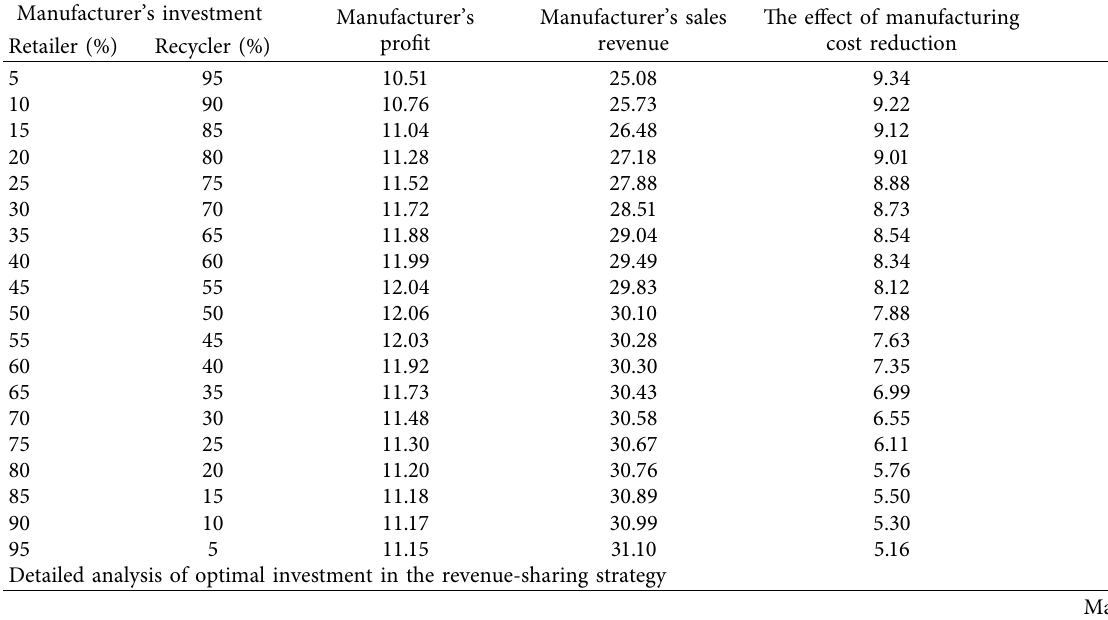
Table 2: Results for the revenue-sharing strategy ( s � 0.65, k � 0.6).